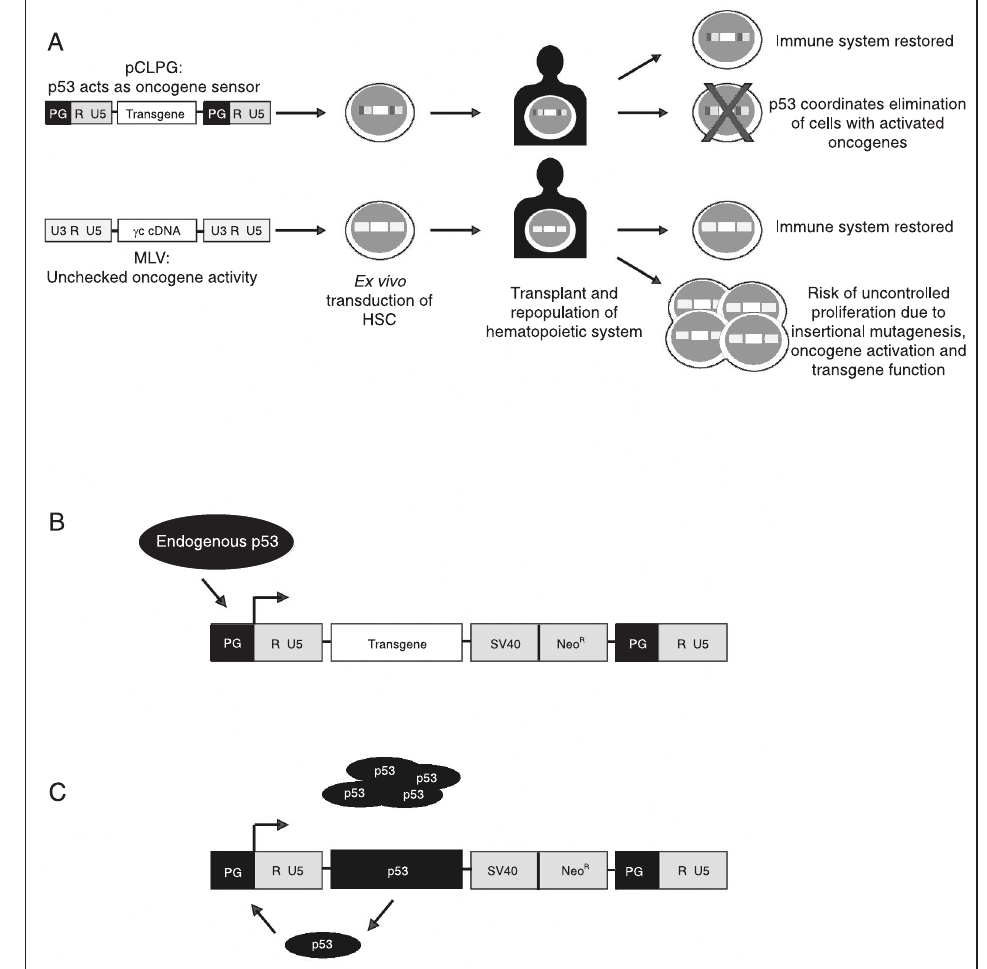
Figure 2. Representation of the events related to oncogene activation during retrovirus-mediated gene therapy. A , We propose that the use of p53 as a transcription factor for our modified retroviral vector, pCLPG, may also serve as an oncogenic sensor since feedback between oncogene, transgene and p53 activities may result in cell death coordinated by p53. Standard murine leukemia virus (MLV) retroviral vectors have been shown to cause uncontrolled proliferation in gene therapy applications. B , The retroviral long-terminal repeat was modified by the removal of the promoter/enhancer region and insertion of the p53-responsive PG element, as described previously (56,57). Endogenous p53 can drive expression of the therapeutic transgene when encoded by the pCLPG retrovirus. We propose that this arrangement may be beneficial for gene therapy of hematopoietic diseases. C , Another use for the pCLPG strategy is the creation of an auto-regulatory cycle, where p53 is encoded by the virus and acts as the activator of viral expression. When p53 transcription is driven by the p53-responsive promoter, a positive feedback loop is established, resulting in high-level expression and superior anti-tumor activity (57). A transgene combination of γ c plus p53 may prove beneficial. HSC = hematopoietic stem